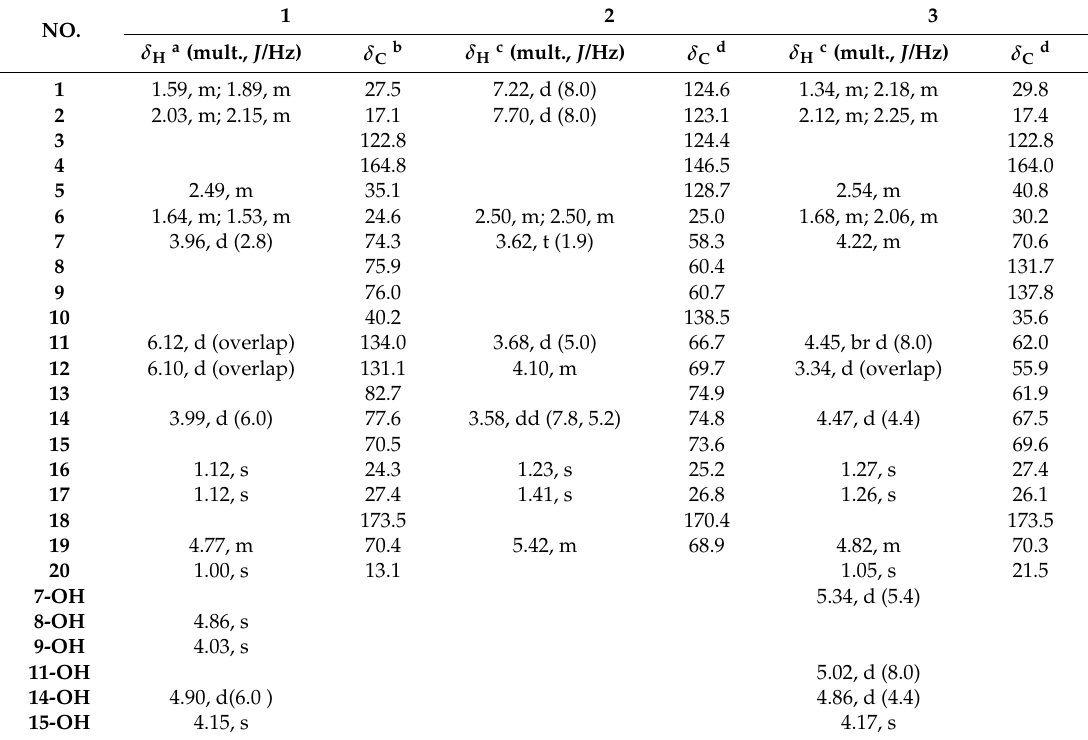
Table 1. 1 H and 13 C NMR data of compounds 1 – 3